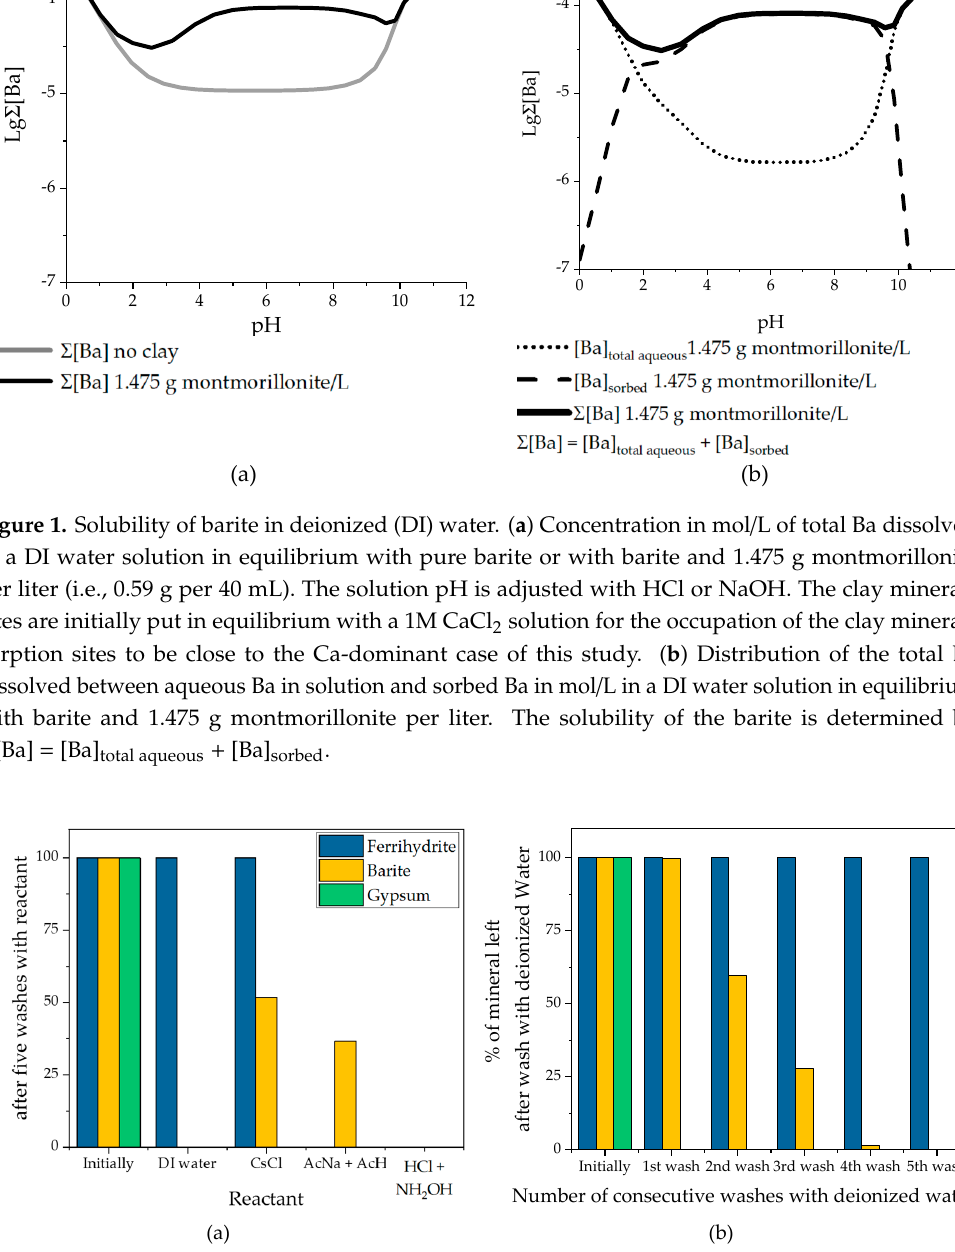
of barite. the reactants [4,61], but not as a part of a mineral assemblage, which greatly influences the dissolution of barite.